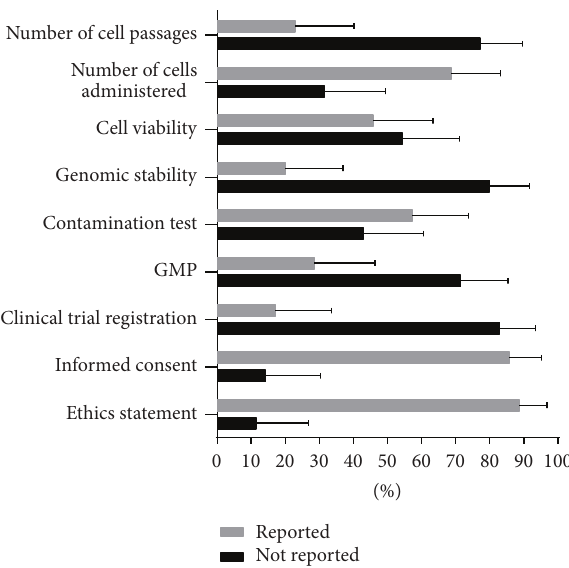
Figure 3: Quality of reporting papers on application of ASC in humans using selected parameters in ethics, safety, and cell characteristics ( 𝑛 = 35 ).